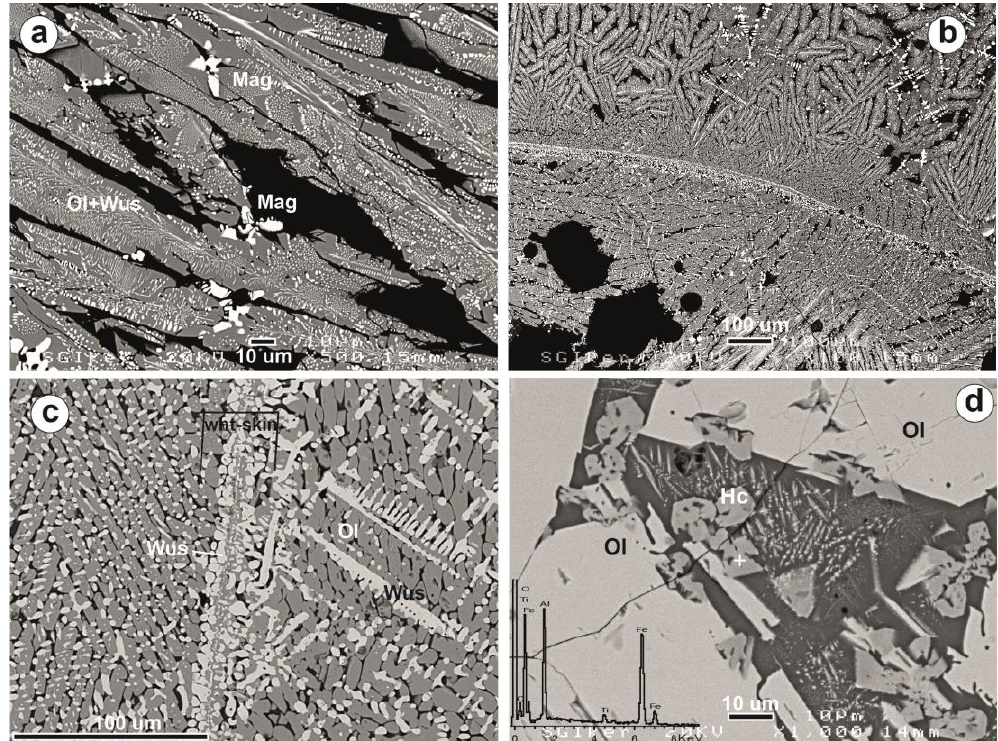
Figure 4. SEM-BSE images. ( a ) skeletal olivines (light-grey colors), dendritic wuestite and cruciform magnetite (white colors) in Group 1. ( b ) white skins and the spinifex olivines in Group 3. ( c ) detail of white skins. ( d ) polyhedral olivines (light-grey colors) and euhedral-cruciform hercynite (grey colors) and EDS spectra of hercynite taken at + spot on the image in Group 3. Abbreviations after